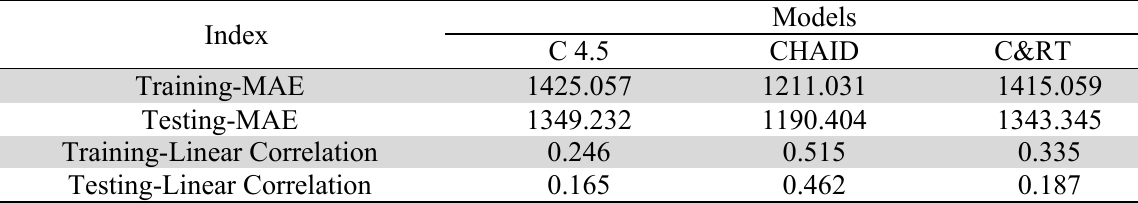
Comparison of the error rates of